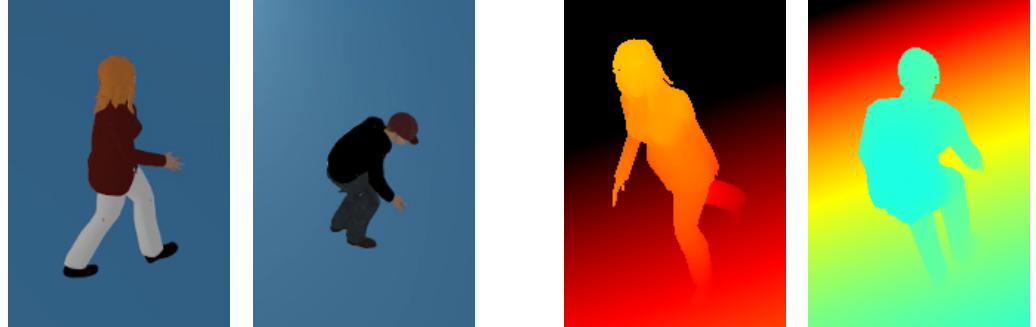
Figure 5. Simulation of human depth maps: ( left ) two examples of human models inside the simulator performing different actions; ( right ) the corresponding depth maps from a simulated Kinect sensor (showing just the part of the depth map close to the